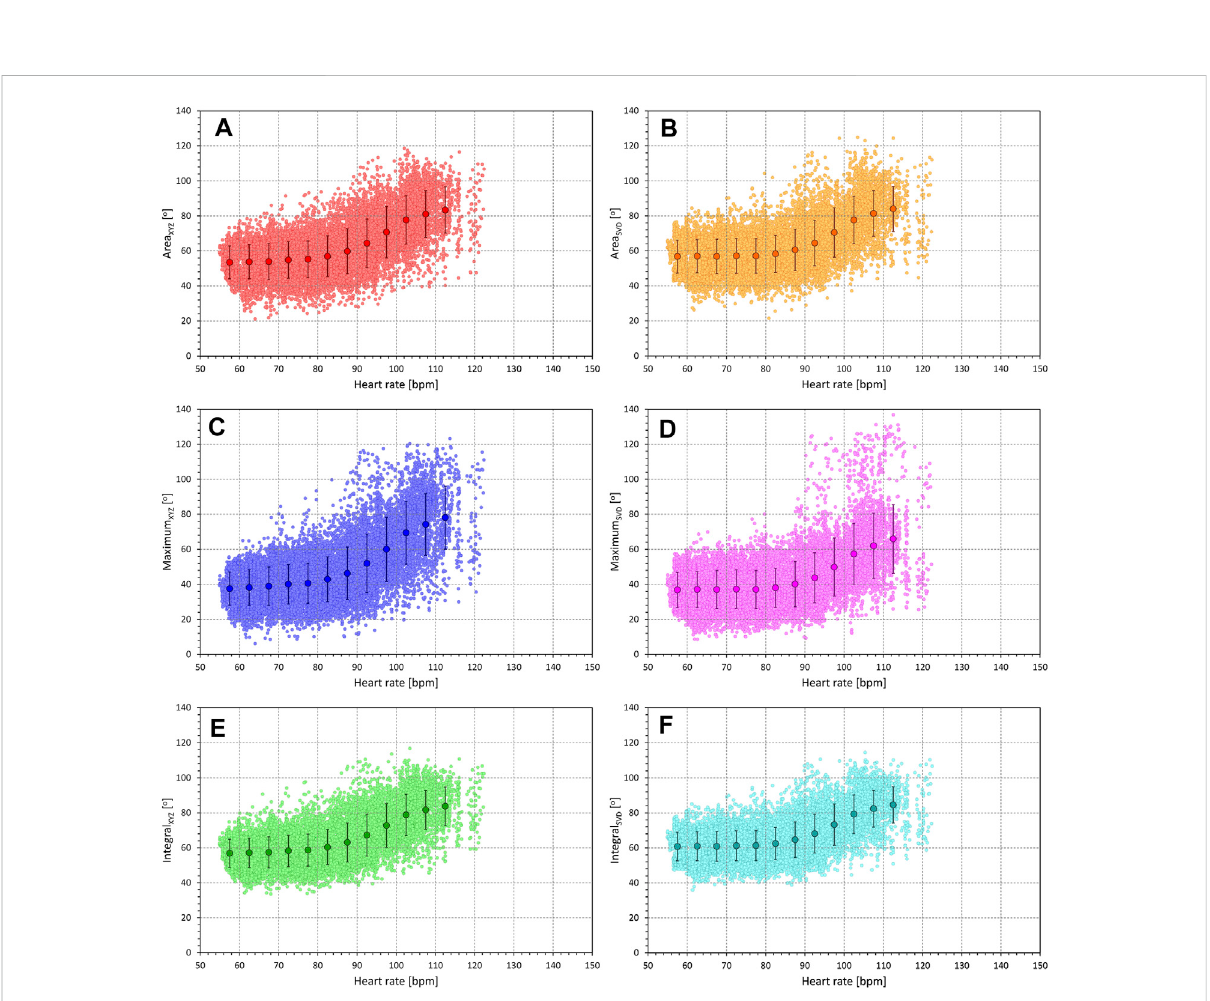
FIGURE 6 Example of the relationship of beat-based measurements of QRS-T angle and the heart rate measured over 1 min preceding each angle measurements.Thedatawereobtainedfromtherecordingsofa21.2-year-oldfemalesubject.Individualpanelsofthe fi gurecorrespondtodifferent QRS-T angle expressions; results corresponding to, Area XYZ , Area SVD , Maximum XYZ , Maximum SVD , Integral XYZ , and Integral SVD angle expressions are shown in panels (A – F) , respectively. In each panel, the individual light-colour small marks correspond to the individual ECG beats data,